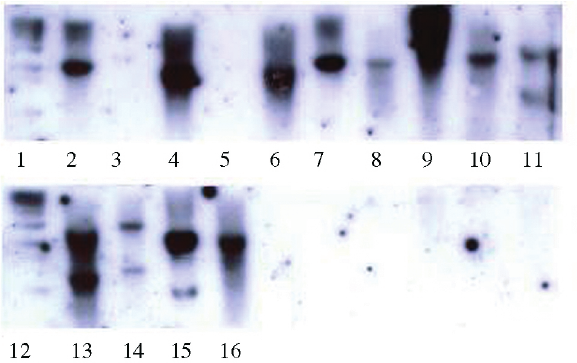
Figure 1 - Hybridization of DNA digested with EcoRI from LEE-positive andLEE-negativestrainstoprobe selC .Lanes1and12:1KbDNAladder; lanes 2 to 10 and 14 to 16: LEE-positive strains: 137/1, 152/1, 173/1, 173/3, 173/2, 178/1, 183/1, 187/3, 231/1, 235/1, 269/1 and 300/2, respec- tively. Lanes 11 and 13 - LEE-negative strains 231/3 and 234/1, respec-